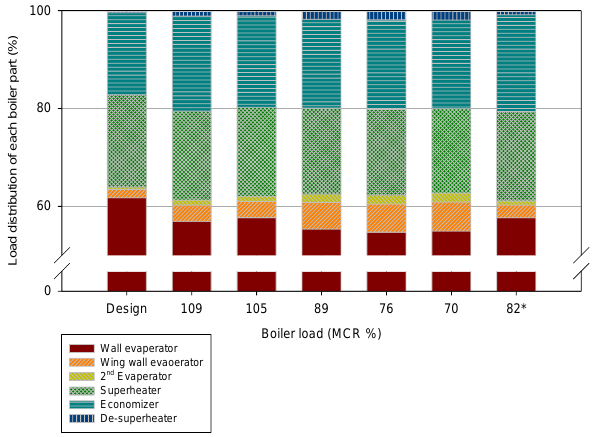
Figure 7. Relative boiler partition by boiler load (* After additional evaporator installation).